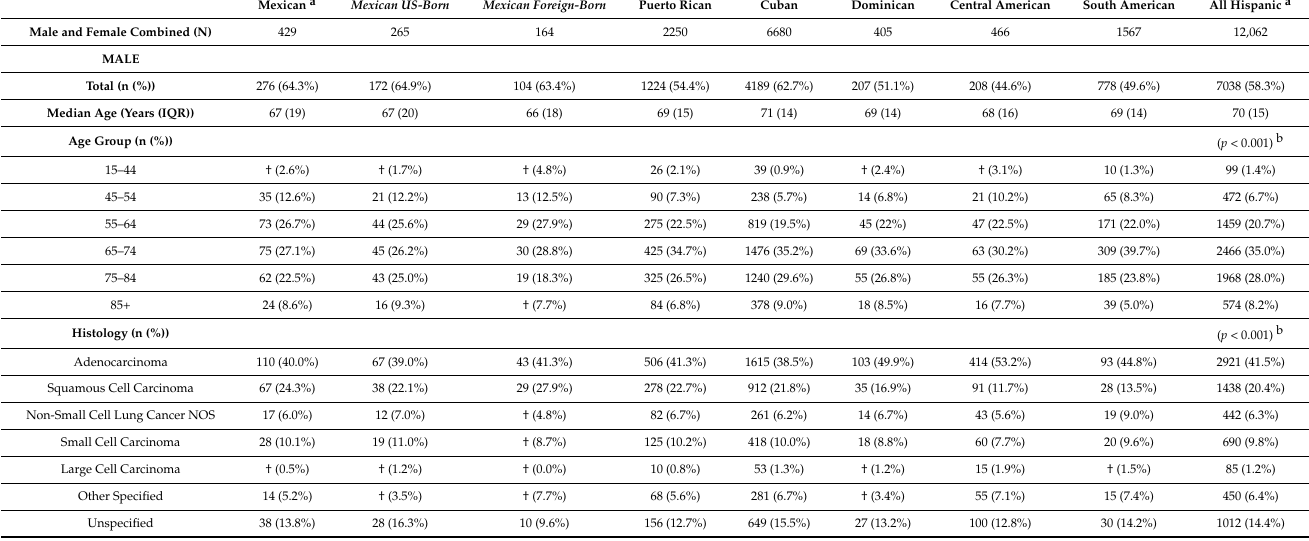
Table 2. Demographic and Clinical Characteristics of Lung Cancer Cases by Hispanic Detailed Race–Ethnicity and Sex. Florida,